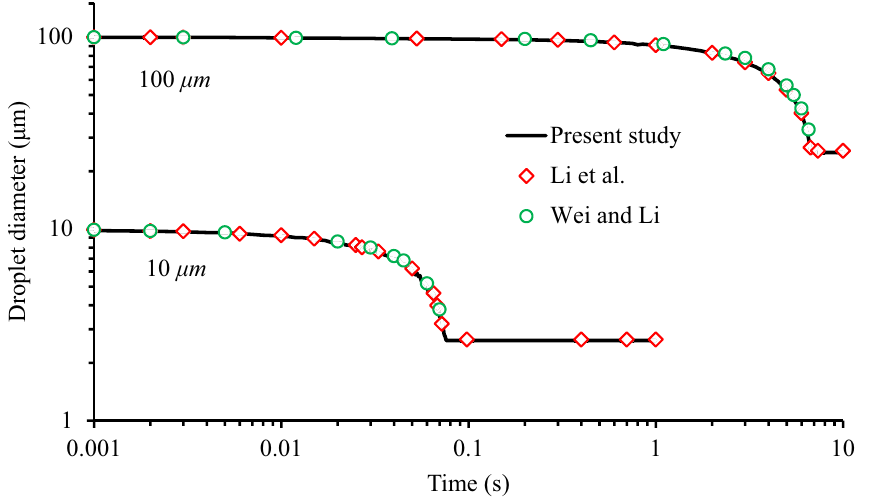
Figure 5. Result of the model validation using data from Li et al. and Wei and Li.